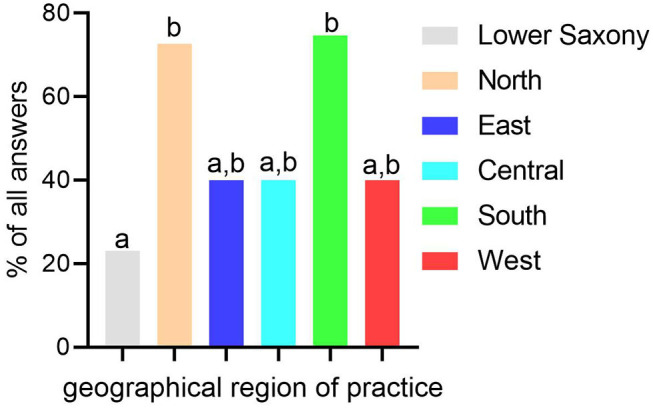
Routine uterine sampling of young maiden mares (<5 years old) for microbiological examination in relation to geographical region of practice in Germany. Geographical region of practice: Lower Saxony = Lower Saxony; North = Mecklenburg-Western Pomerania, Schleswig-Holstein; East = Brandenburg, Saxony, Saxony-Anhalt; Central = Hesse, Rhineland-Palatinate, Saarland, Thuringia; South = Baden-Wuerttemberg, Bavaria; West = North Rhine-Westphalia. Columns with different superscripts (a,b) represent statistically significant difference among groups (p < 0.05).